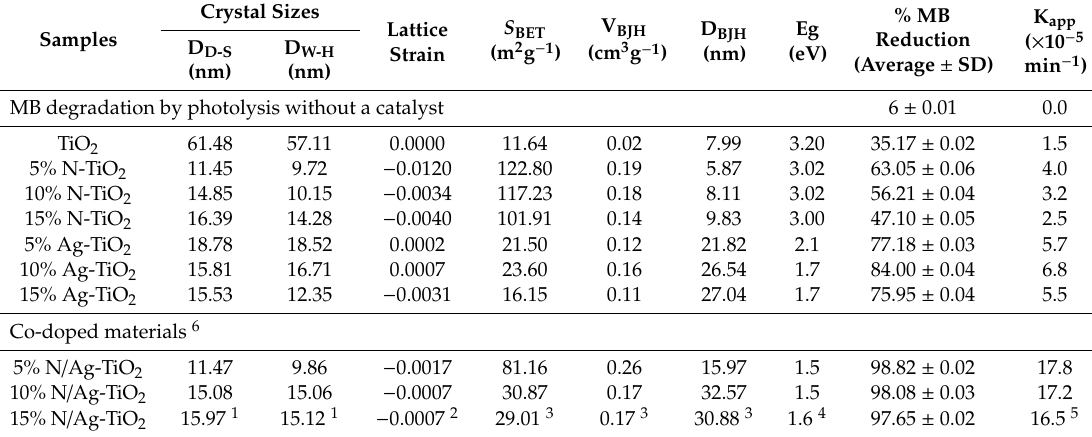
Table 1. Characteristic information and photocatalytic performance of MB degradation under visible LED irradiation in 6 h of di ff erent prepared photocatalysts, including the data for MB degradation by photolysis without a